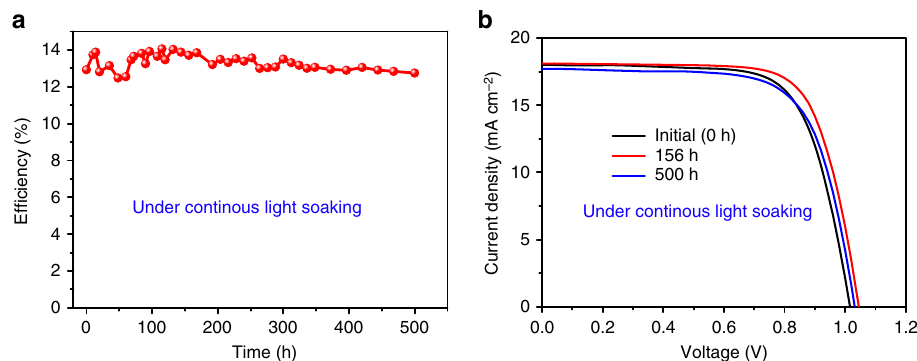
Fig. 4 Photostability of the CsPbI 3 solar cells. a Photostability measurement of the devices under continuous one-sun illumination (100 mW cm − 2 ) with UV cut fi lter (420 nm) in nitrogen glove box (temperature: approximately 25 °C) for the unencapsulated devices. b J – V curve of the devices under different continuous